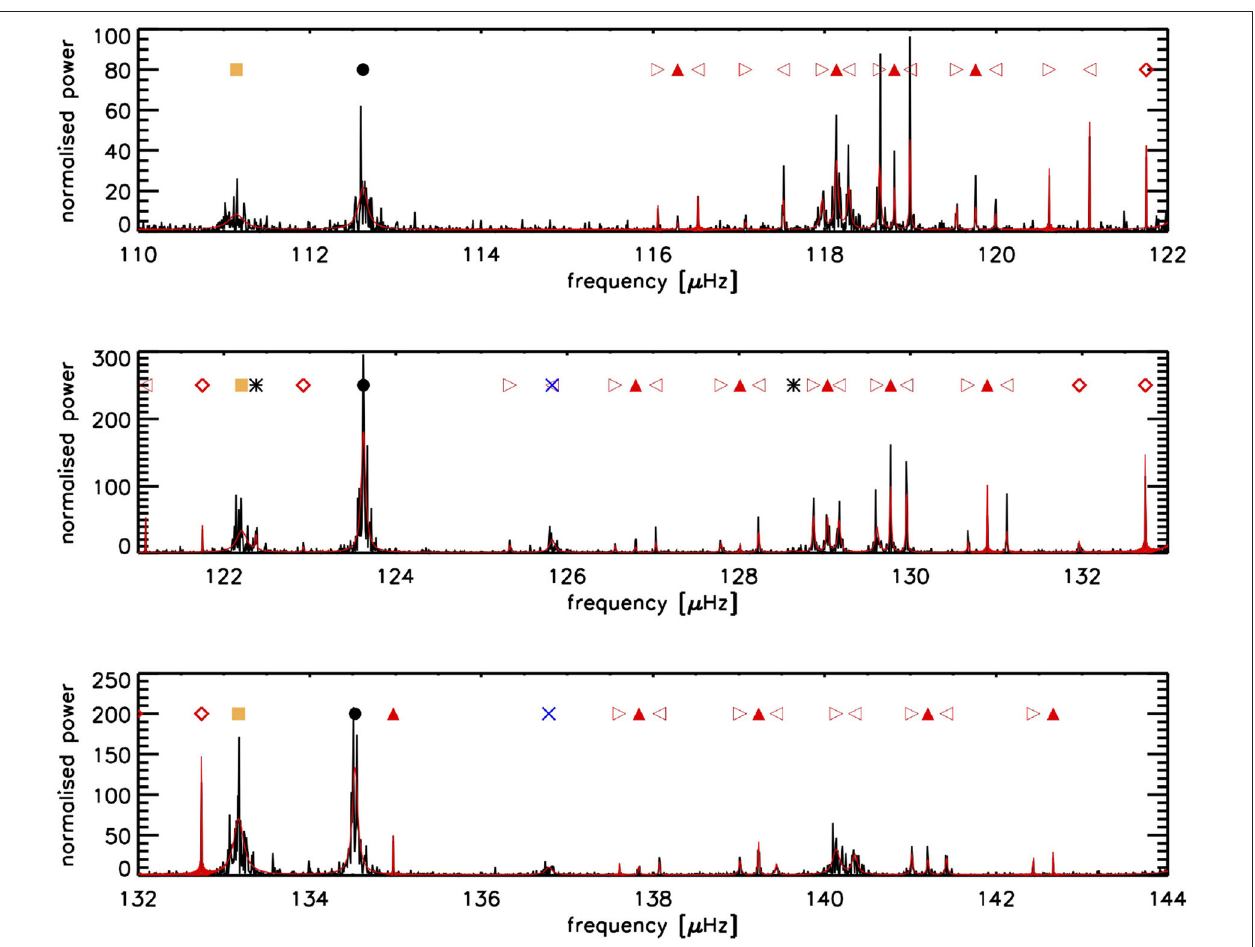
FIGURE 4 | A close look into the region of the three radial orders closest to ν max in the power density spectrum of KIC 6144777. Each row focuses on one radial mode and the adjacent l 1 and l 2 modes. The fit to the data as computed with TACO (Hekker et al., in prep) is indicated in red. The radial, dipole, quadrupole = = and octupole modes are indicated with black dots, red triangles, orange squares and blue crosses, respectively. Note that there are multiple dipole modes associated with each radial mode—these are the mixed modes. Additionally, the dipole modes show rotational splitting, where the m right and left pointing open triangles respectively. Dipole modes for which the azimuthal order could not (yet) be identified are indicated with red diamonds. Modes for which no identification could be obtained are indicated with black